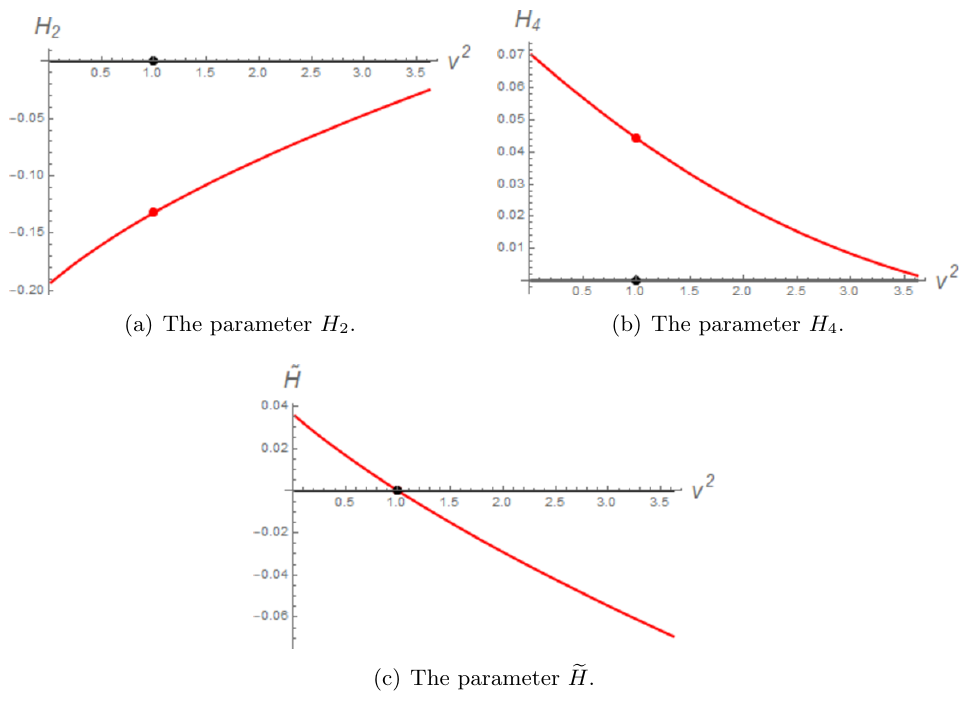
Figure 6 . The parameters of H 2 ; H 4 ; e H in terms of the squashing v 2 , for (cid:11) = 0 : 82 (red). For q 8 (cid:11) = they vanish identically 11